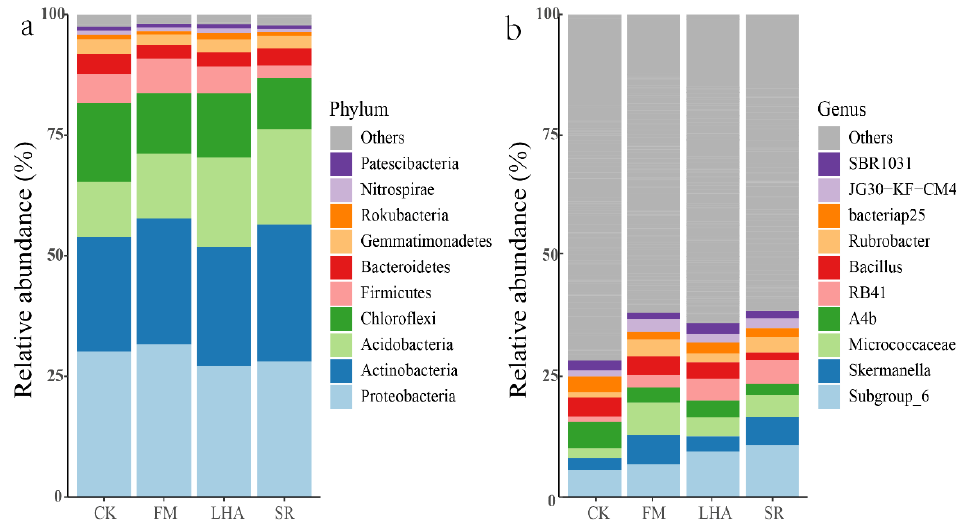
Figure 2. The relative abundances of the top 10 dominant phyla ( a ) and the top 10 dominant genera ( b ) in bulk soil.